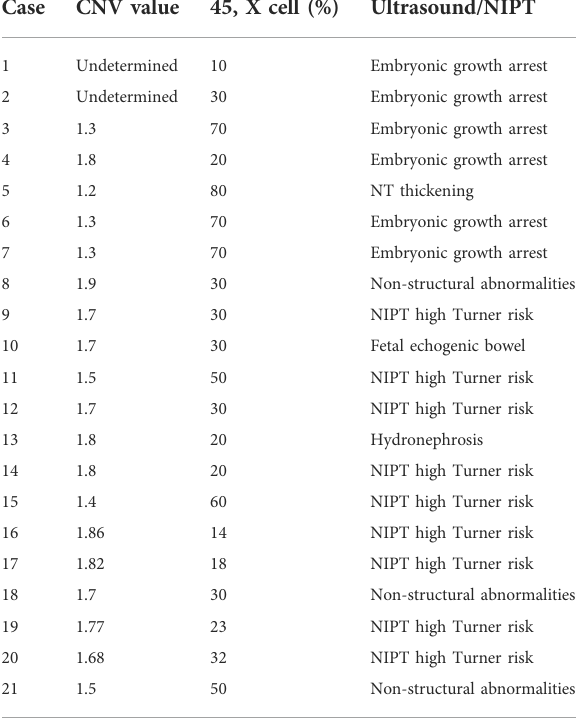
TABLE 2 CNVs and percentage of mosaic Turner